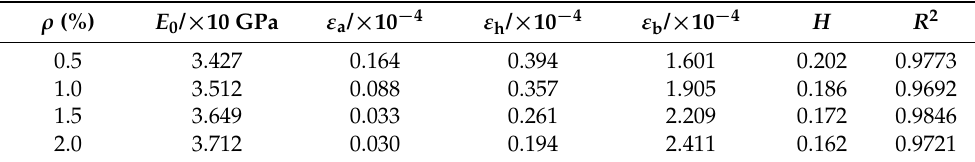
Figure 11. Stress – strain curves under uniaxial tension: ( a ) nominal stress – strain curve (Plan view); ( b ) effective stress – Figure 11. Stress–strain curves under uniaxial tension: ( a ) nominal stress–strain curve (Plan view); ( b ) effective stress–strain strain curve (Plan view); ( c ) envelope of the nominal stress – strain curve (3D view); ( d ) envelope of the effective stress – curve (Plan view); ( c ) envelope of the nominal stress–strain curve (3D view); ( d ) envelope of the effective stress–strain curve strain curve (3D view). (3D view). Table 4. Results for calculation parameter. Table 4. Results for calculation